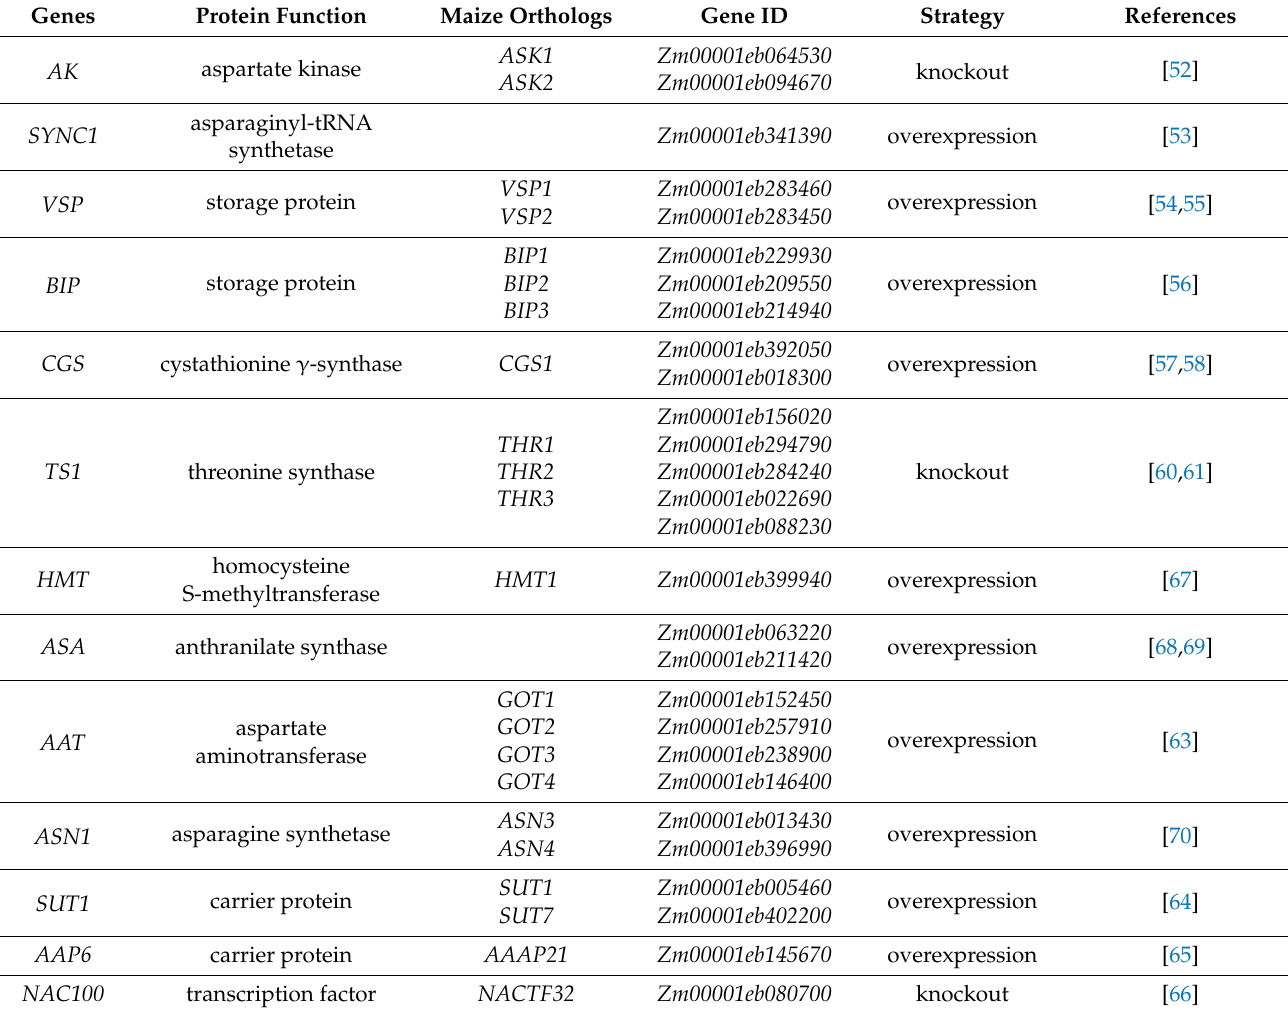
Table 3. List of potential gene resources for elevating essential amino acid content in